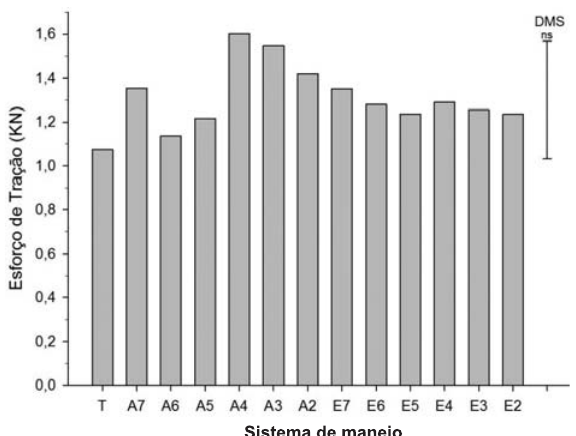
Figura 1. Esforço de tração em um Latossolo Vermelho distrófico húmico manejado sob Sistema Plantio Direto, submetido à aração há 7,5 anos (A7), 6,5 anos (A6), 5,5 anos (A5), 4,5 anos (A4), 3,5 anos (A3) e 2,5 anos (A2), à escarificação há 7,5 anos (E7), 6,5 anos (E6), 5,5 anos (E5), 4,5 anos (E4), 3,5 anos (E3) e 2,5 anos (E2) e há 16 anos sob Sistema Plantio Direto contínuo (T). Obs.: A barra vertical corresponde à diferença mínima significativa pelo teste de Tukey a 5